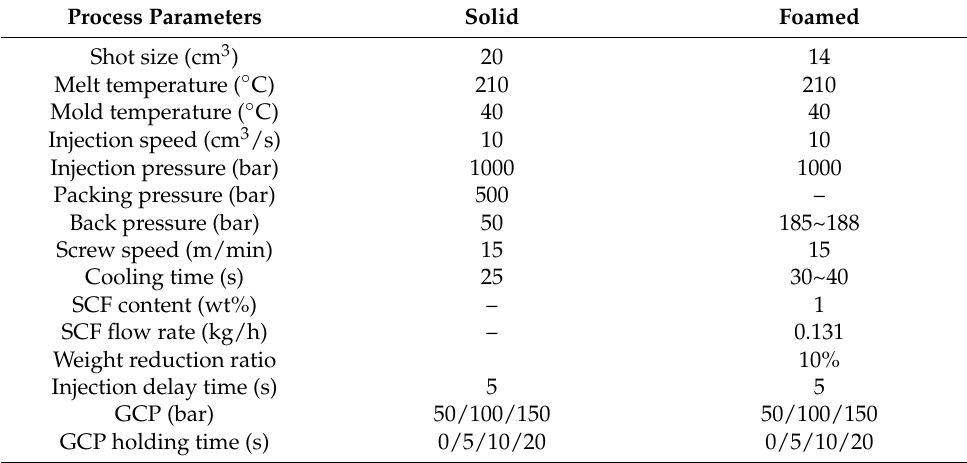
Table 1. Process parameters both for conventional and Mucell molding